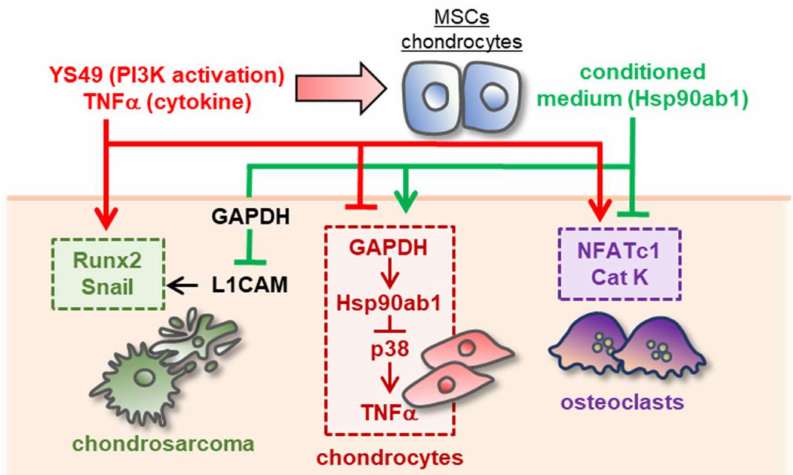
Figure 8. Schematic diagram for the putative regulatory mechanism with MSC/chondrocyte-derived CM. The activation of PI3K signaling or the administration of TNF α generated the chondroprotective MSC/chondrocyte-derived CM. The CM suppressed tumor progression via the GAPDH-L1CAM axis and downregulated TNF α by inhibiting p38 signaling. It also blocked the differentiation of bone-resorptive osteoclasts by downregulating NFATc1 and cathepsin K. By contrast, the activa- tion of PI3K or the administration of TNF α to CS and chondrocytes stimulated tumorigenic and inflammatory